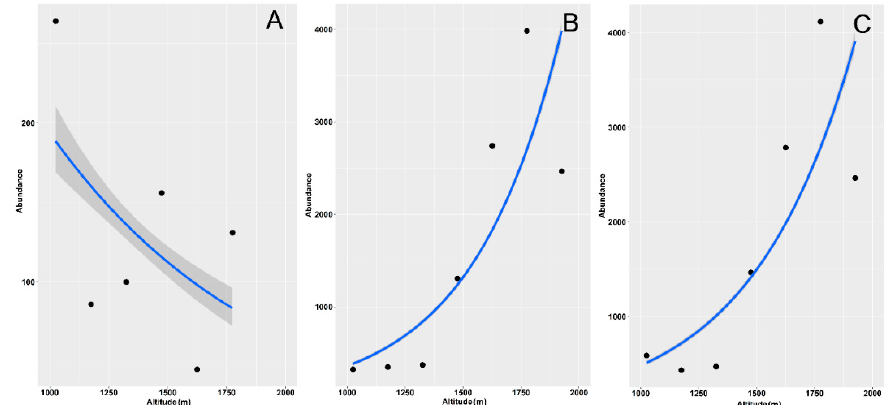
Figure 3. Relationship between dung beetle species abundance and altitude along an elevational gradient in central Italy. Curves were constructed using standardized abundance values for the two habitats (woodlands and grasslands) separately (woodlands: ( A ), grasslands: ( B ) and merged ( C )). General linear models were used for fitting. Dashed areas are 95% confidence intervals. Confidence intervals in panels ( B , C ) are not distinguishable because of their narrowness.